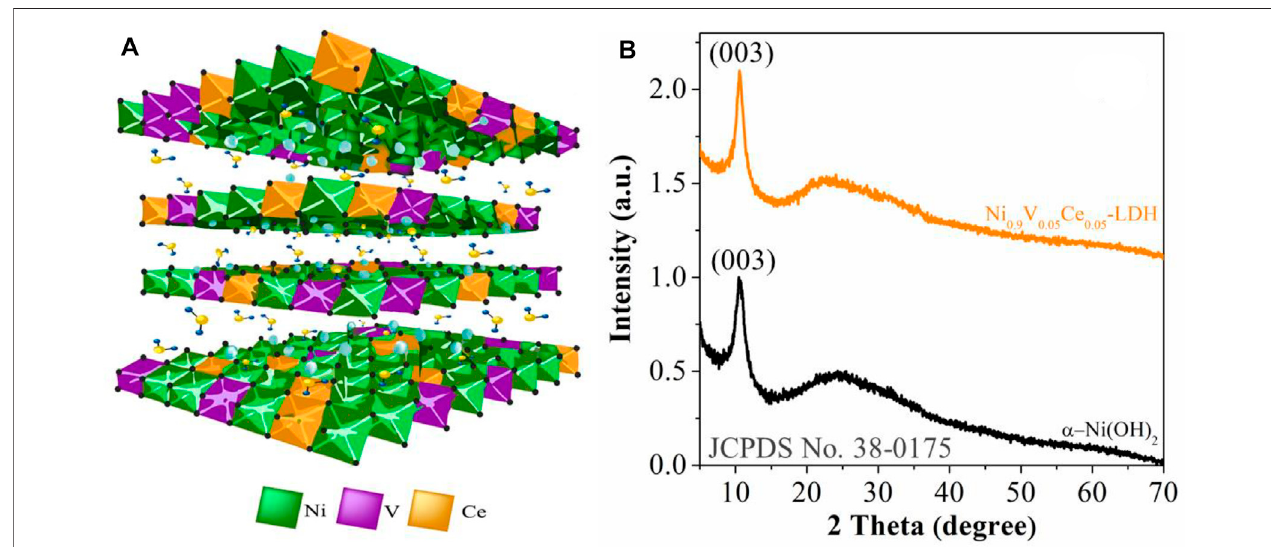
FIGURE 1 | (A) Scheme depicting lateral view of Ni 0.9 V 0.05 Ce 0.05 -LDH. (B) X-ray diffractograms of α -Ni(OH) 2 and Ni 0.9 V 0.05 Ce 0.05 -LDH NPs deposited on a glass slip